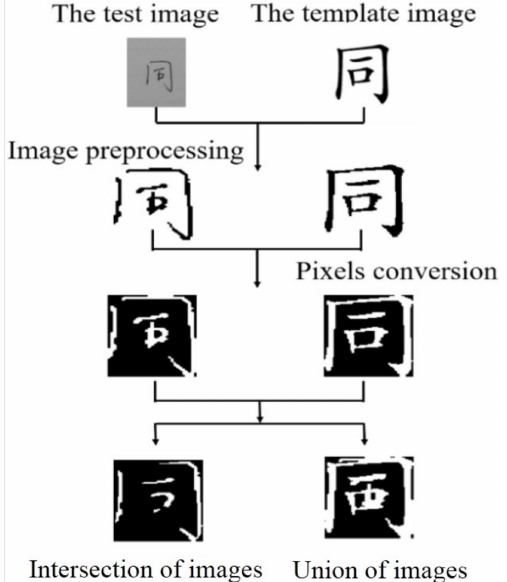
Figure 6. Schematic illustration of pixel coincidence degree method for Chinese Character “ 同 ” (means